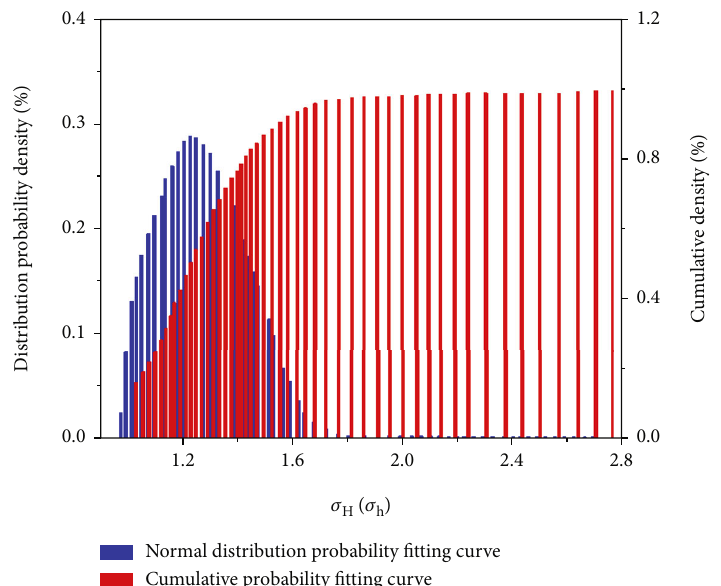
Figure 6: Probability distribution and fi tting curve of the horizontal stress ratio.